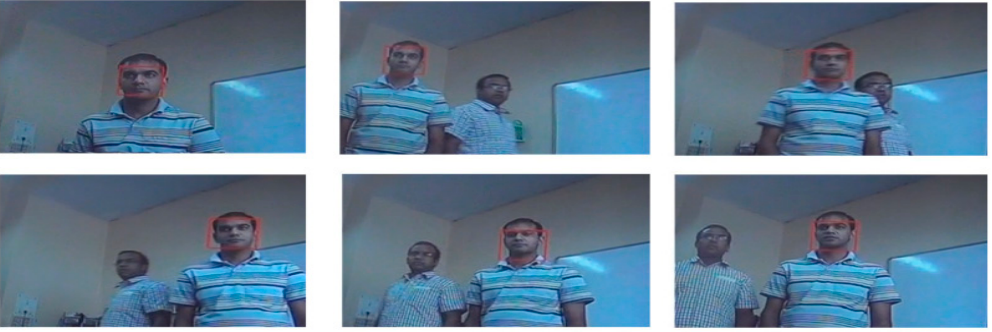
Figure 15. Frame sequence showing object tracking in the presence of other moving objects in the scene.